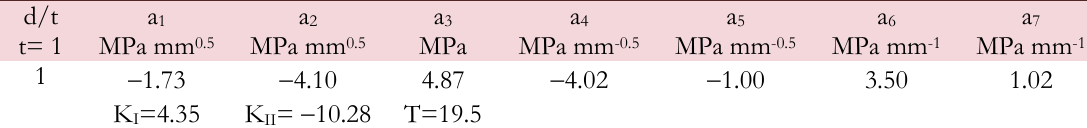
Table 1. Parameters of the stress field, overlap